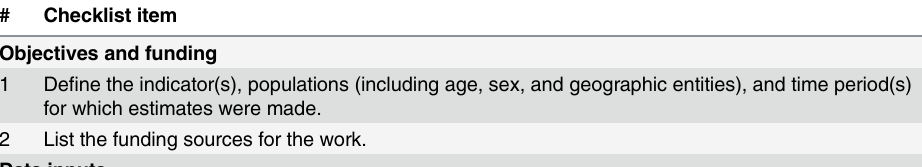
Table 1. GATHER checklist of information that should be included in reports of global health